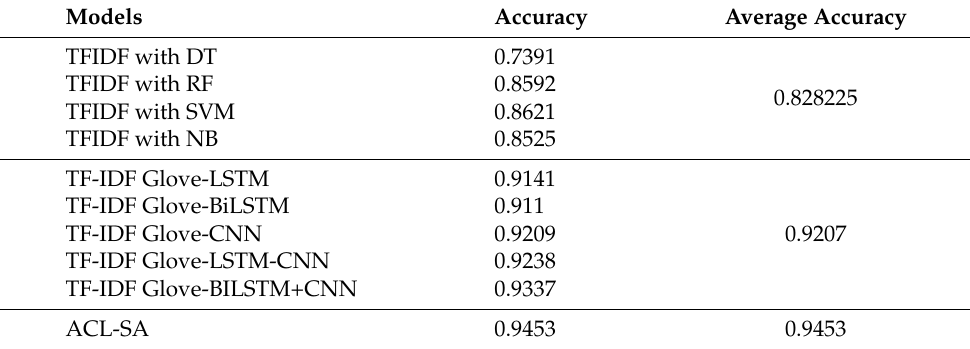
Table 6. SD4A accuracy compression with baseline models and our proposed models.